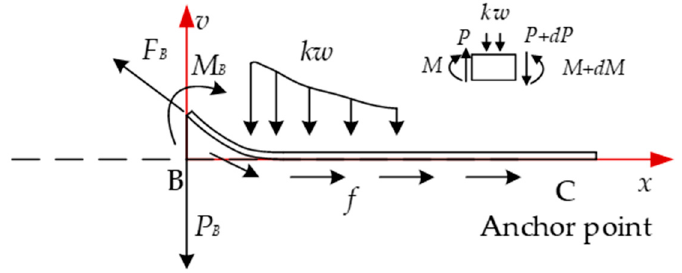
Figure 3. Mechanical model for pipe segment (BC) in non-liquefaction zone.